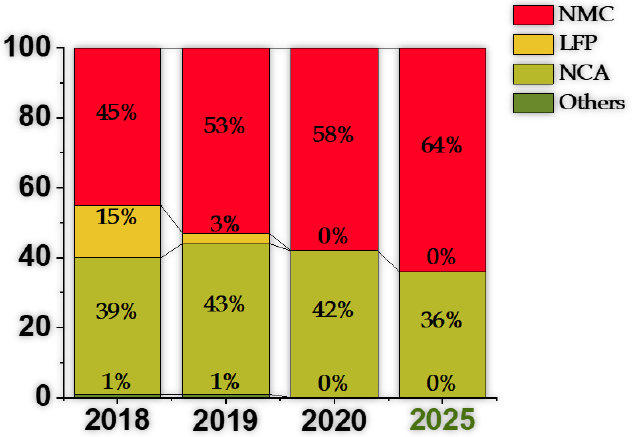
Figure 1. Adoption rate per chemistry in electrical vehicle (EV) battery Market. Adapted from the source